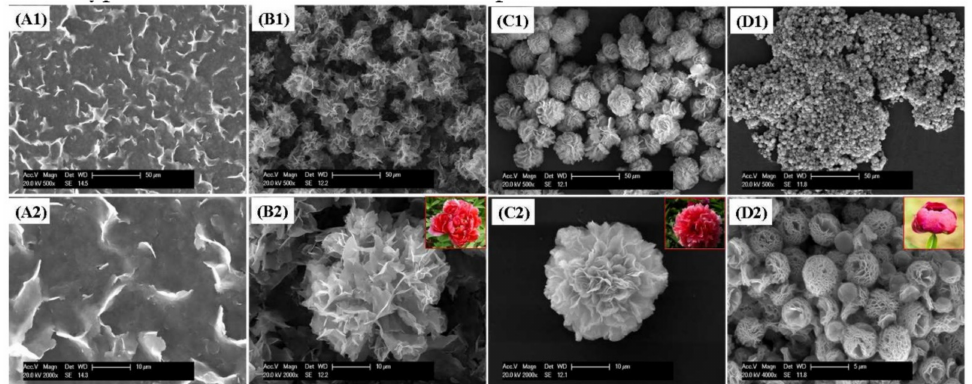
Figure 5. SEM image of different trypsin concentrations on the formation of nanoflowers: ( A1 , A2 ) 0.0 mg/mL, ( B1 , B2 ) 0.02 mg/mL, ( C1 , C2 ) 1.0 mg/mL, and ( D1 , D2 ) 5.0 mg/mL. Reprinted from [23] with permission from the Royal Society of Chemistry. Copyright © The Royal Society of Chemistry. License Number: